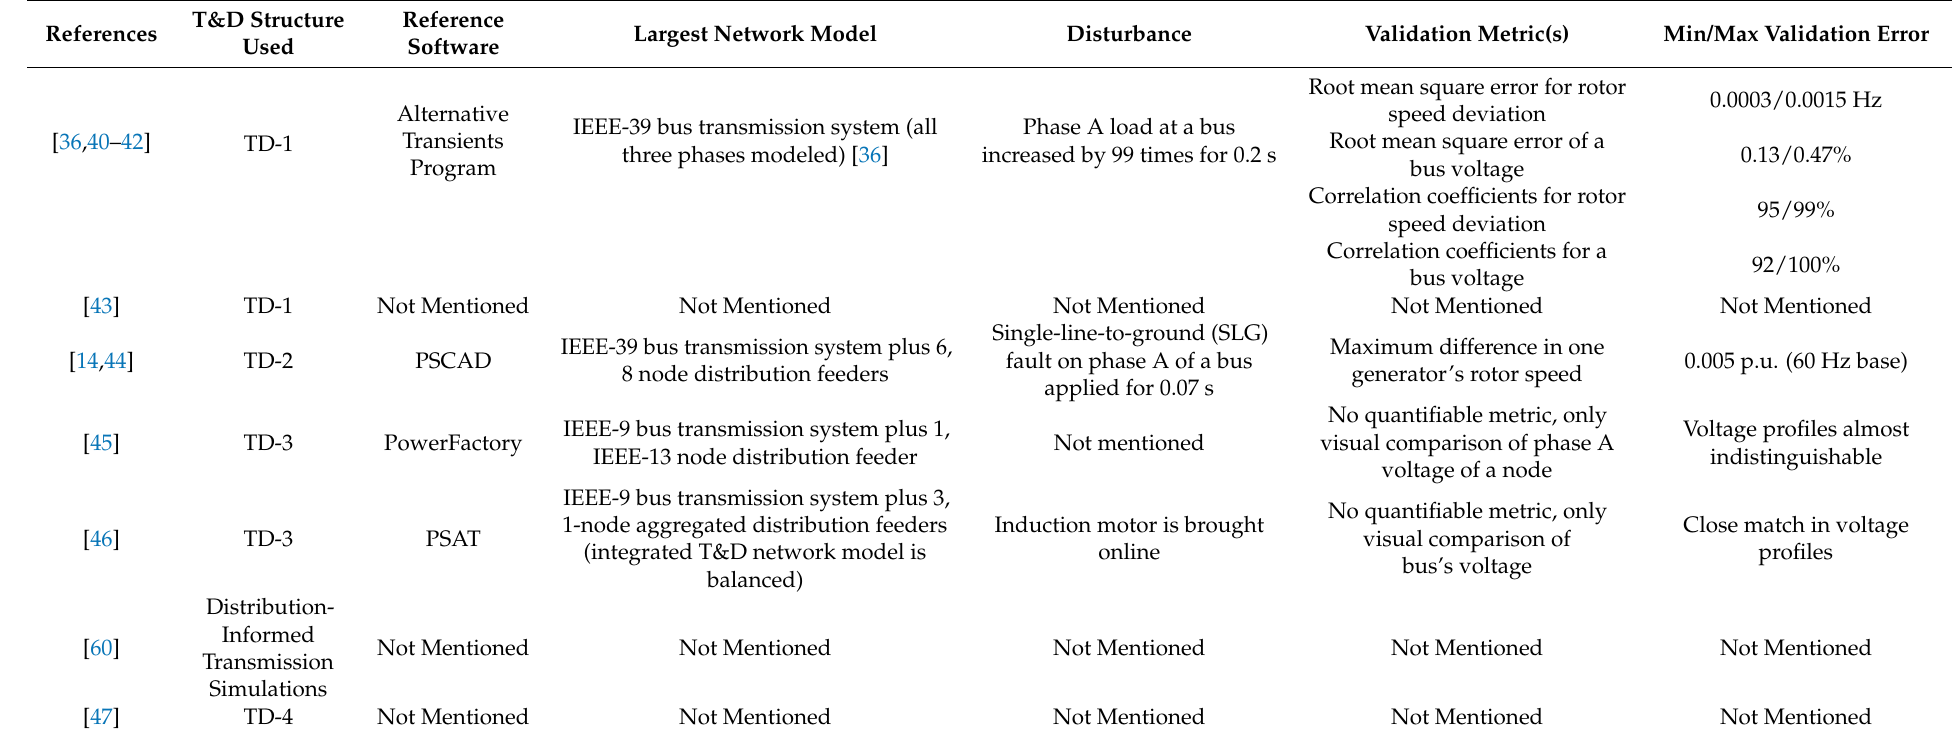
Table 4. Numerical comparison of validation approaches/performance of integrated T&D dynamics modeling and simulation